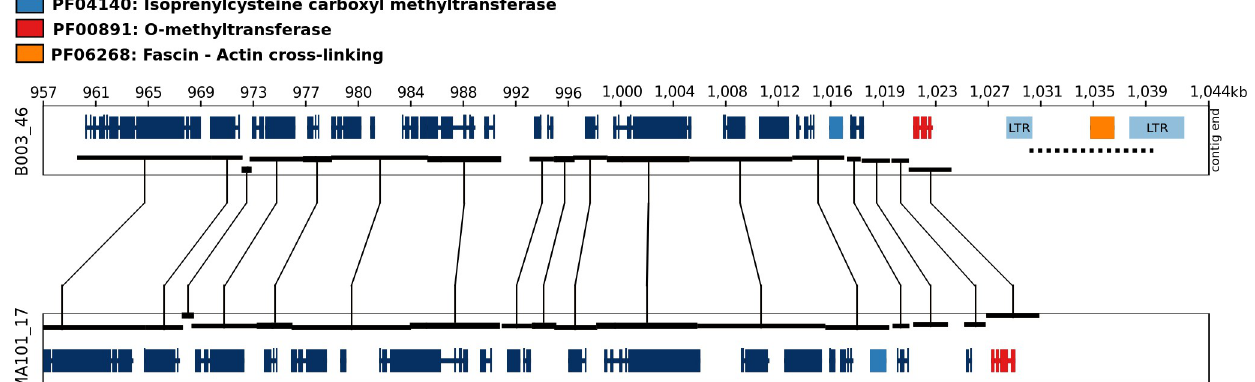
Fig 3. Genomic location of the 20 most significant k-mers associated with previously published phenotype data of 25 Eutypa lata isolates [6]. Synteny blocks between isolates B003 (k-mer containing isolate) and MA101 (absence of k-mers) are represented with black linked boxes. The mapping genomic location of long-reads containing the 20 most significant k-mers (p-value 6.65e-7) in the genome of isolate B003 is denoted with a dotted line. Pfam domains for neighbouring genes are indicated in the legend. The presence/absence of these kmers and the phenotype data are available in S7 Table.